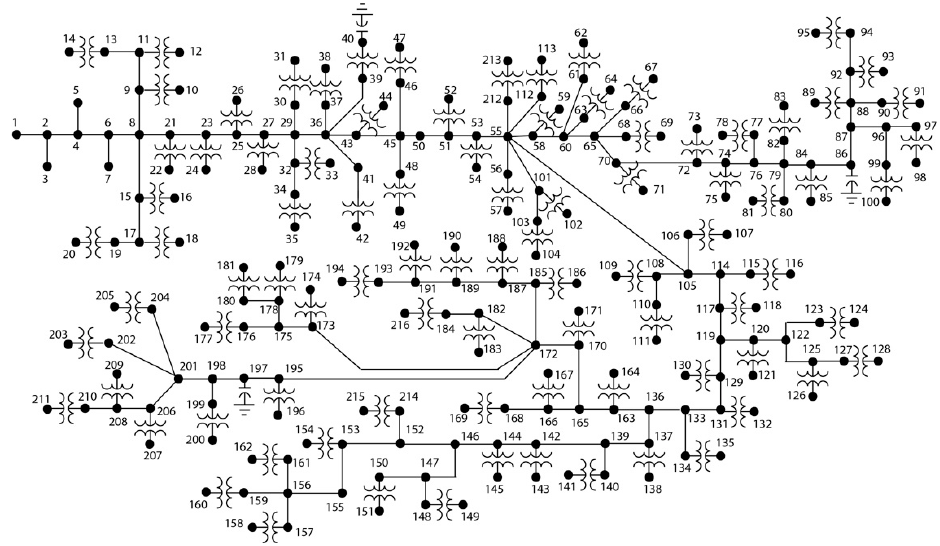
Figure 12. Single-line diagram of PD06 feeder.